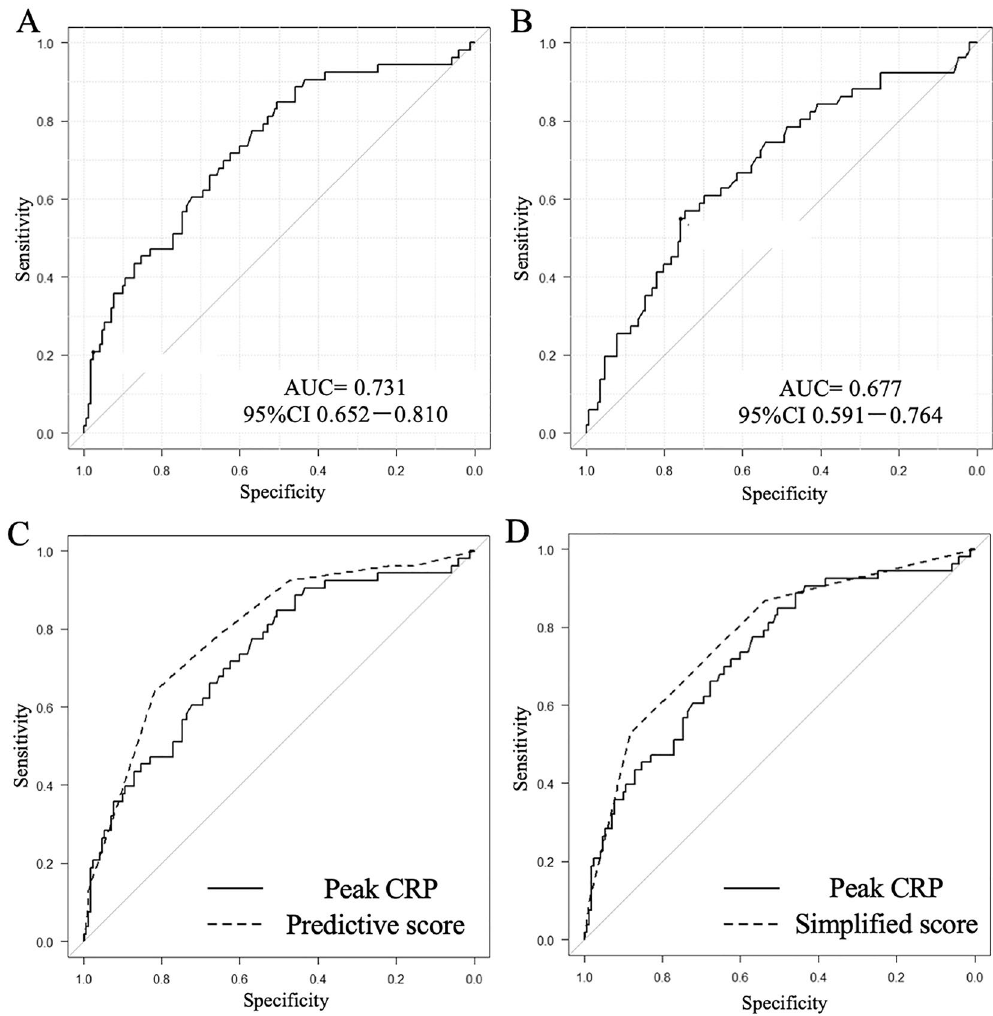
Figure 3. Receiver operating characteristic (ROC) curve of peak C-reactive protein level ( A ) and D-dimer level ( B ) for in-hospital hypoxemia in patients with type-B acute aortic syndrome. Comparison of the ROC curve between the peak CRP level (AUC 0.731; 95% CI 0.652–0.81) and the predictive score for hypoxemia (AUC 0.791; 95% CI 0.723–0.859) ( C ). Comparison of the ROC curve between the peak CRP level (AUC 0.731; 95% CI 0.652–0.81) and the simplified score for predicting hypoxemia (AUC 0.777; 95% CI 0.707–0.847) ( D